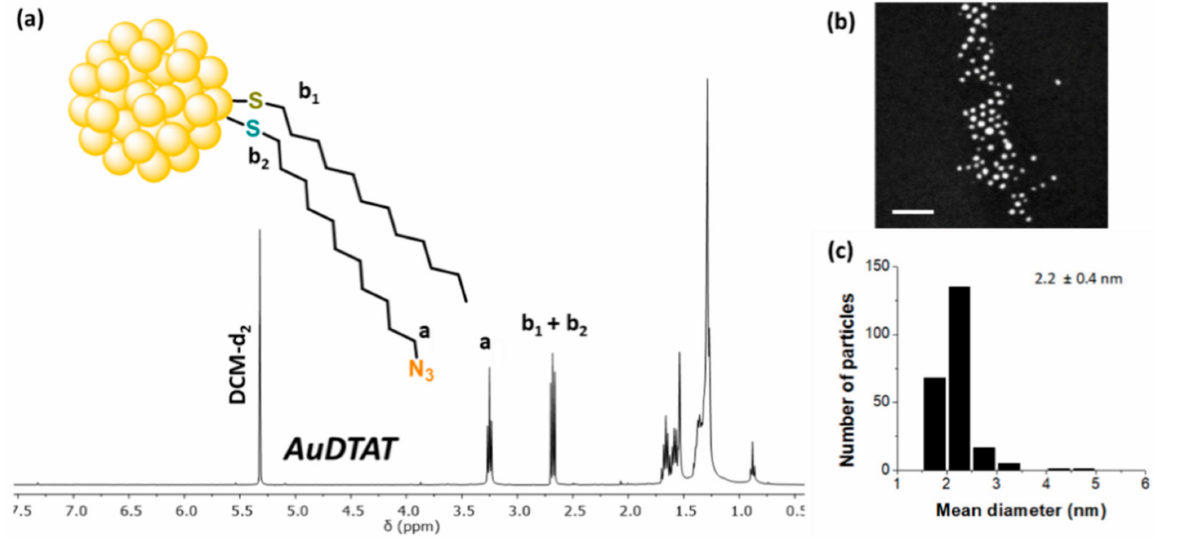
Figure 1. ( a ) 1 H-NMR spectra in deuterated dichloromethane (DCM-d 2 ) solution at 25 ◦ C (left), ( b ) TEM micrograph (top-right), and ( c ) NP size distribution histogram (bottom-right) for AuDT-AT. In each TEM specimen, 200 to 250 particles at least have been measured from different micropho- tographs obtained from different areas of the grid. Table 2. Mean diameter, statistical dispersity, and percentage of dodecane-1-thiol, 11-azidoundecane- 1-thiol and dendrimeric ligands (% molar) in the gold